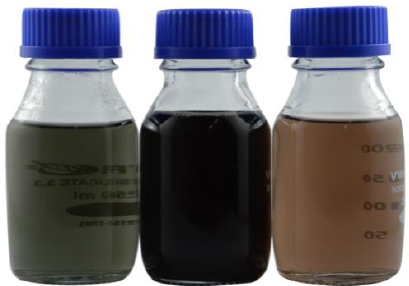
Figure 5. The photograph of parent SWCNT dispersion ( middle ) and collected post-separation phases: top (semiconducting, right ) and bottom (metallic, left ). Top and bottom phases were diluted with H 2 O (top in ratios 1:4, bottom in ratios 1:40) for a clear illustration of colors.